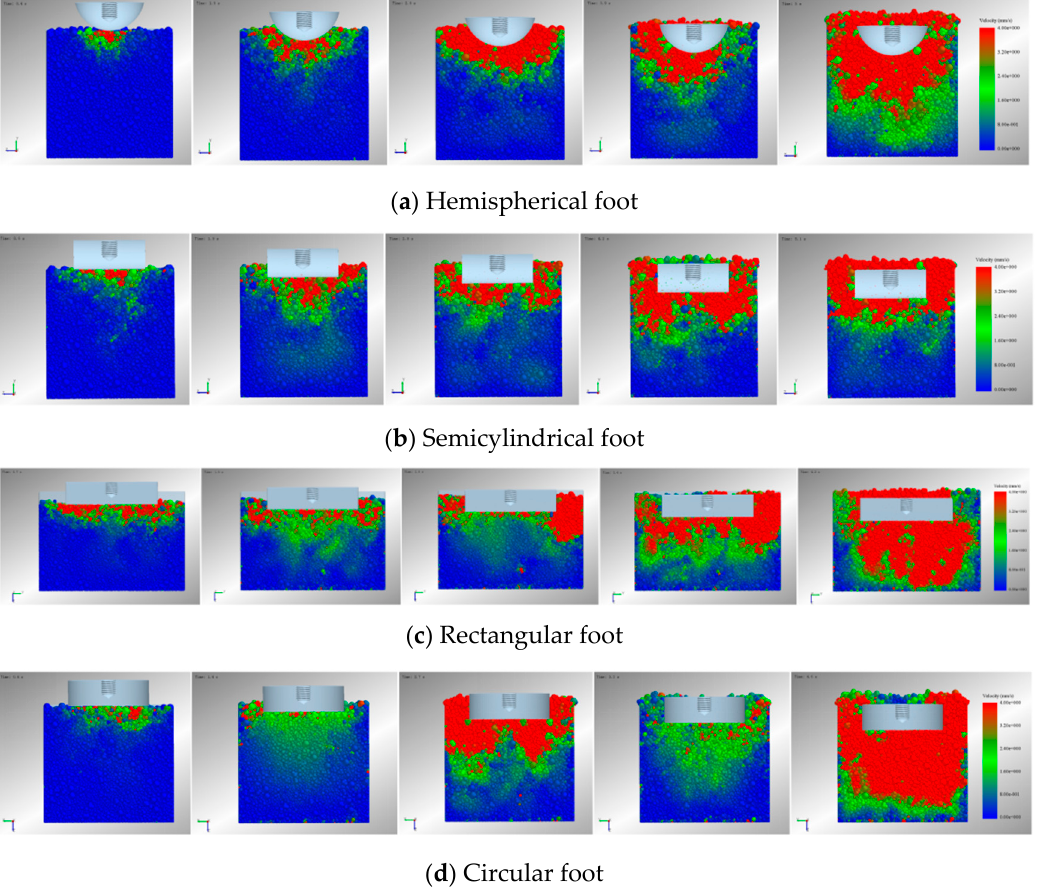
Figure 12. The variations in particle velocity field during the intrusion of mechanical feet into quartz sand